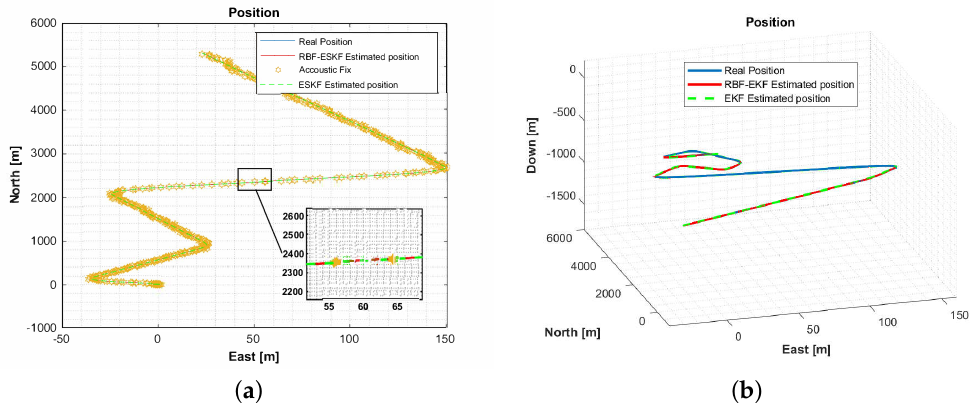
Figure 4. ( a ) A comparison of the 2D trajectory of an underwater vehicle in the east and north directions and ( b ) a comparison of the 3D trajectory of an underwater